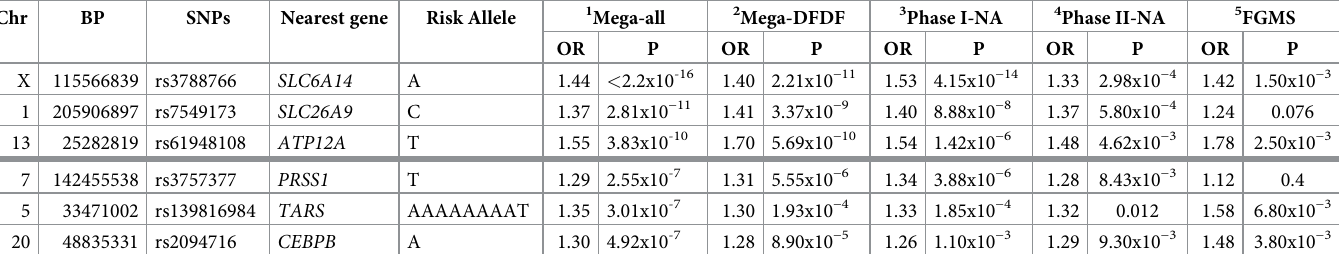
Table 2. Top ranked variants by p-value from each genome-wide significant locus in the GMC sample of 6,770 individuals with CF. The first three rows correspond to loci with SNPs that reached genome-wide significance and the bottom three rows correspond to loci with SNPs that exceeded false discovery rate (FDR) control thresh- old of q = 0.05 (equivalent to p < 7.67x10 -7 ). The top SNP in the SLC6A14 region remains the same at rs3788766 as in [12], while the top SNP at the SLC26A9 locus is now rs7549173. However all significant loci reported at the SLC26A9 locus in [12] are in linkage disequilibrium with rs7549173 (S3 Table), including rs7512462 which has been used as an instrumental variable in a Mendelian Randomization analysis of CF-related diabetes and shown to associate with exocrine pancreas disease [15] and CFTR- directed therapeutics response [2]. The variants in the ATP12A and PRSS1 regions in the previous study [12] are provided in S3 Table. The chromosome 5 and 20 variants are new findings and were not previously identified in